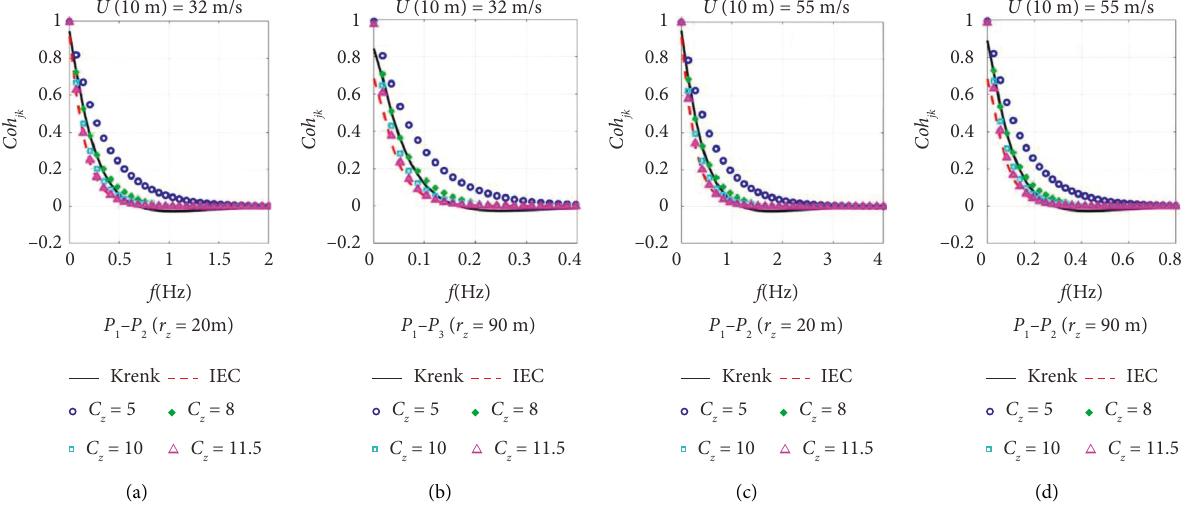
Figure 2: Comparison of root-coherence functions for along-wind loads.